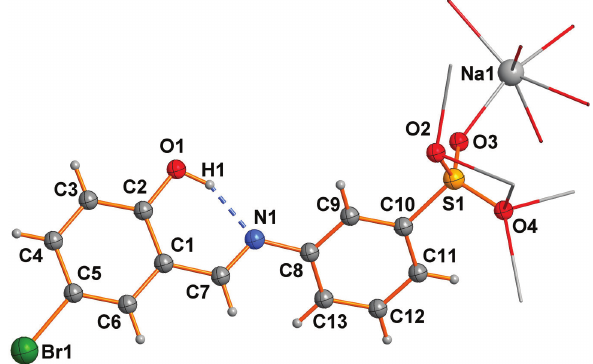
Table 1: Data collection and handling.